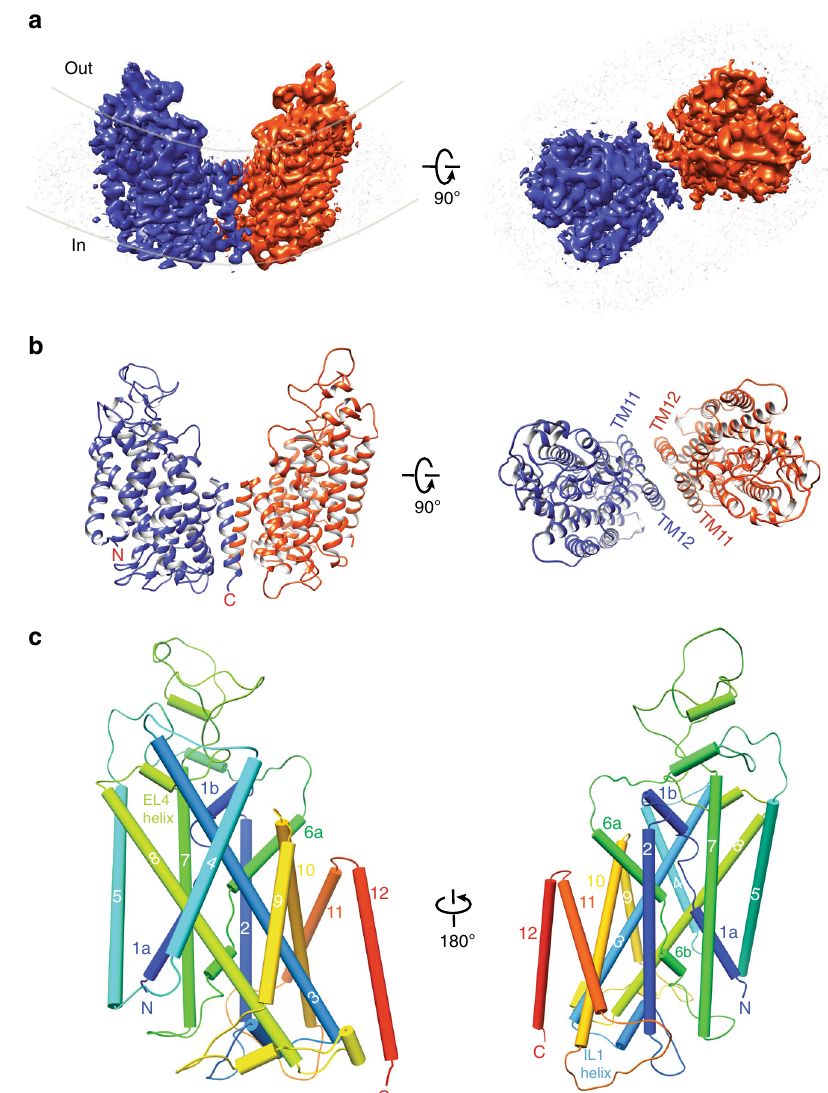
Fig. 1 Human NKCC1 structure determined by single-particle cryo-EM. a Side and extracellular views of NKCC1 embedded in detergent micelles. Individual transporter subunits are color-coded. Densities of the detergent micelle are rendered semi-transparent and shown in light gray. Two lines (light gray) denote the outer and inner membrane layer, highlighting the curve architecture of NKCC1 dimer. b Ribbon representations of NKCC1 dimer are shown in same orientations and colored-coded as in panel ( a ). c An NKCC1 subunit is shown in cylinders with rainbow colors from the N- to